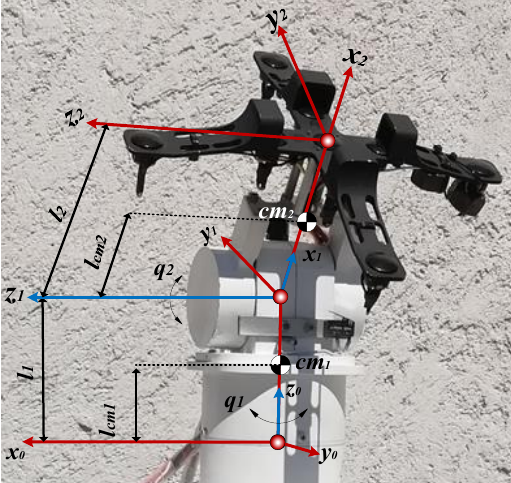
Figure 10. Experimental test bed of the solar tracking system.